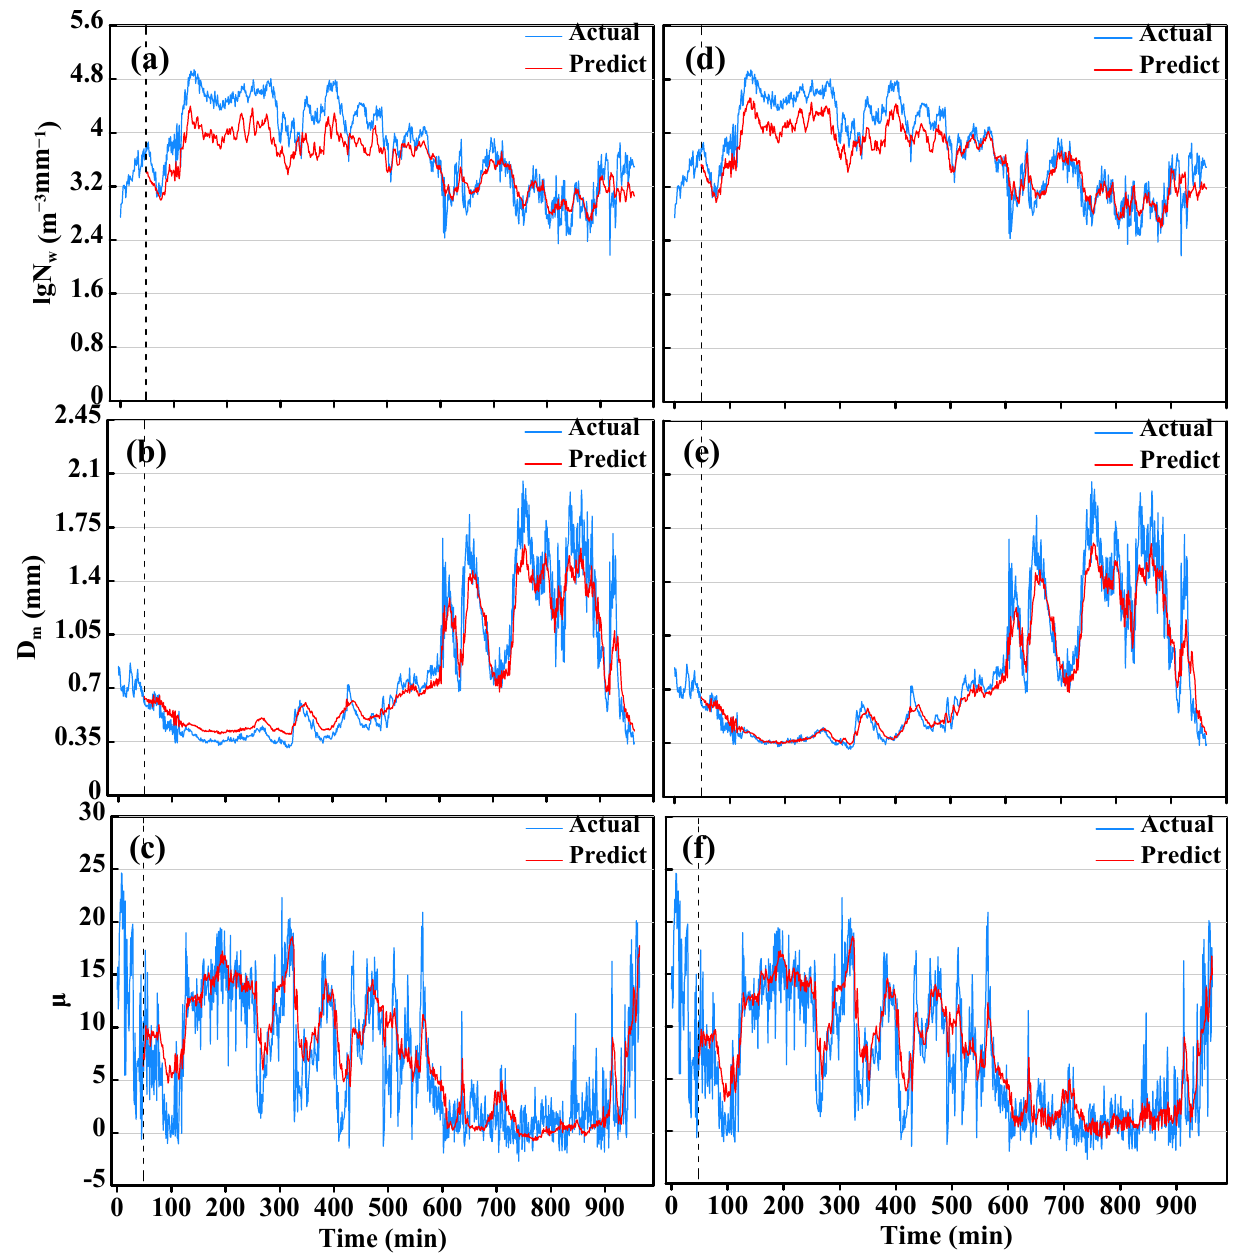
Figure 13. The curve of the 30-min prediction for the mixed convective–stratiform cloud precipitation case, in which the horizontal axes are rainfall duration time (min); vertical axes are ( a , d ) lgN w , ( b , e ) D m (mm), and ( c , f ) μ; the red and blue curves represent the predicted and actual values; and the vertical dotted line is at the minute of T step + M pred . Modeling with MLF is shown on the left ( a – c ), and with SLF on the right ( d – f ).